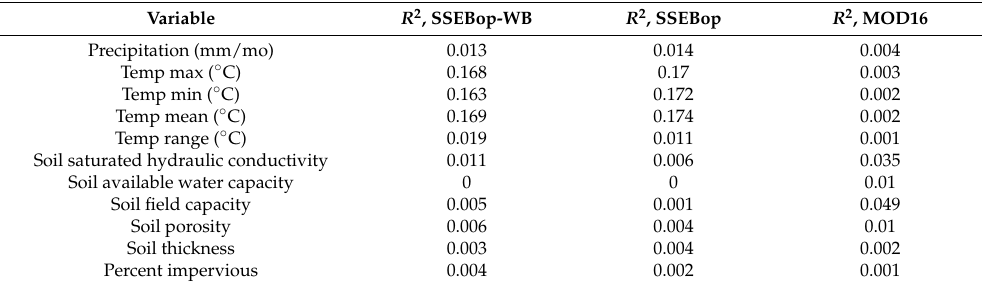
Table 3. Correlations of residuals with other measured quantities at tower locations, to check for potential sources of systematic bias in the algorithms. All correlations except for soil available water capacity and soil thickness showed a statistical significance of p < 0.05.